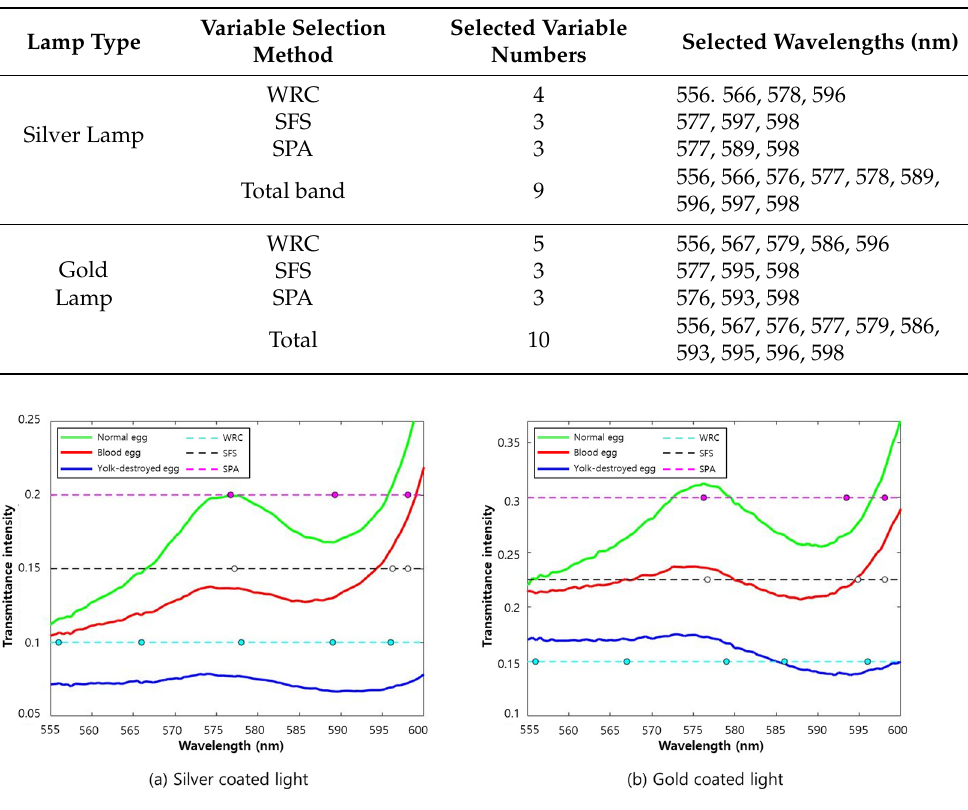
Figure 11. Graphical representation of the selected wavebands using the three variable selection methods. ( a ) Silver-coated halogen model; ( b ) gold-coated halogen model. Table 3. Band selection results using a forward stepwise regression model to a gold- and silver-coated lamp model.